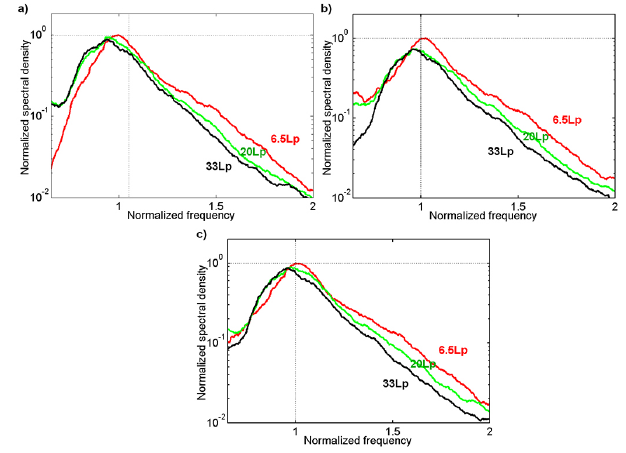
Figure 6. Evolution along the tank of the high-frequency spectral counterparts of the mixed crossing seas: (a) θ =60 ◦ , (b) θ =120 ◦ and (c) θ =90 ◦ .